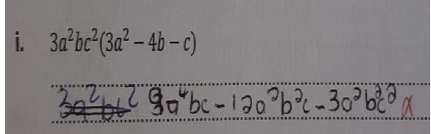
Figure 6: Experimental learner AR, School Y.